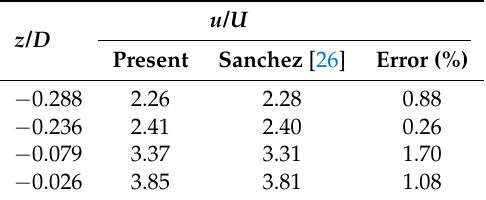
Table 1. Percentage error in maximum velocity at Re D = 365 and β = 1.97 for some positions ( z / D ). u / U z / D